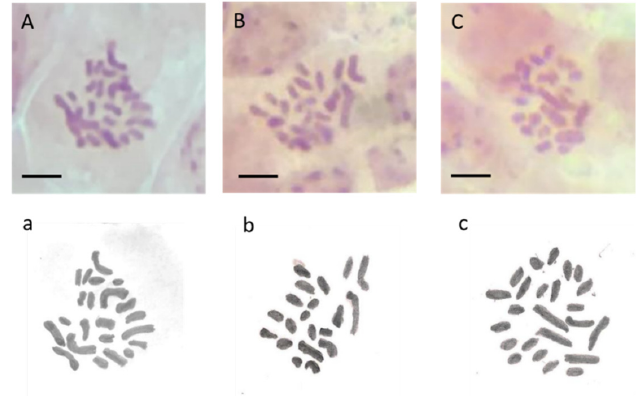
Figure 1. Chromosomes count on A. spinosa : microscopic photography (A, B, C) and draw (a, b, c) of meta-phasic plate showing 22 chromosomes, 20 chromosomes and 24 chromosomes. Scale bars represent 5 µm.